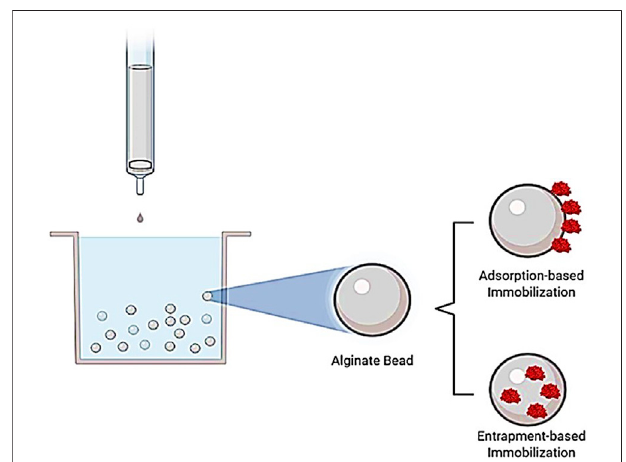
FIGURE 1 | Representation of adsorption- and entrapment-based immobilization methods. In the adsorption-based immobilization method, the soluble enzyme attaches to solid support, whereas the soluble enzyme is entrapped in a support material in the entrapment-based immobilization